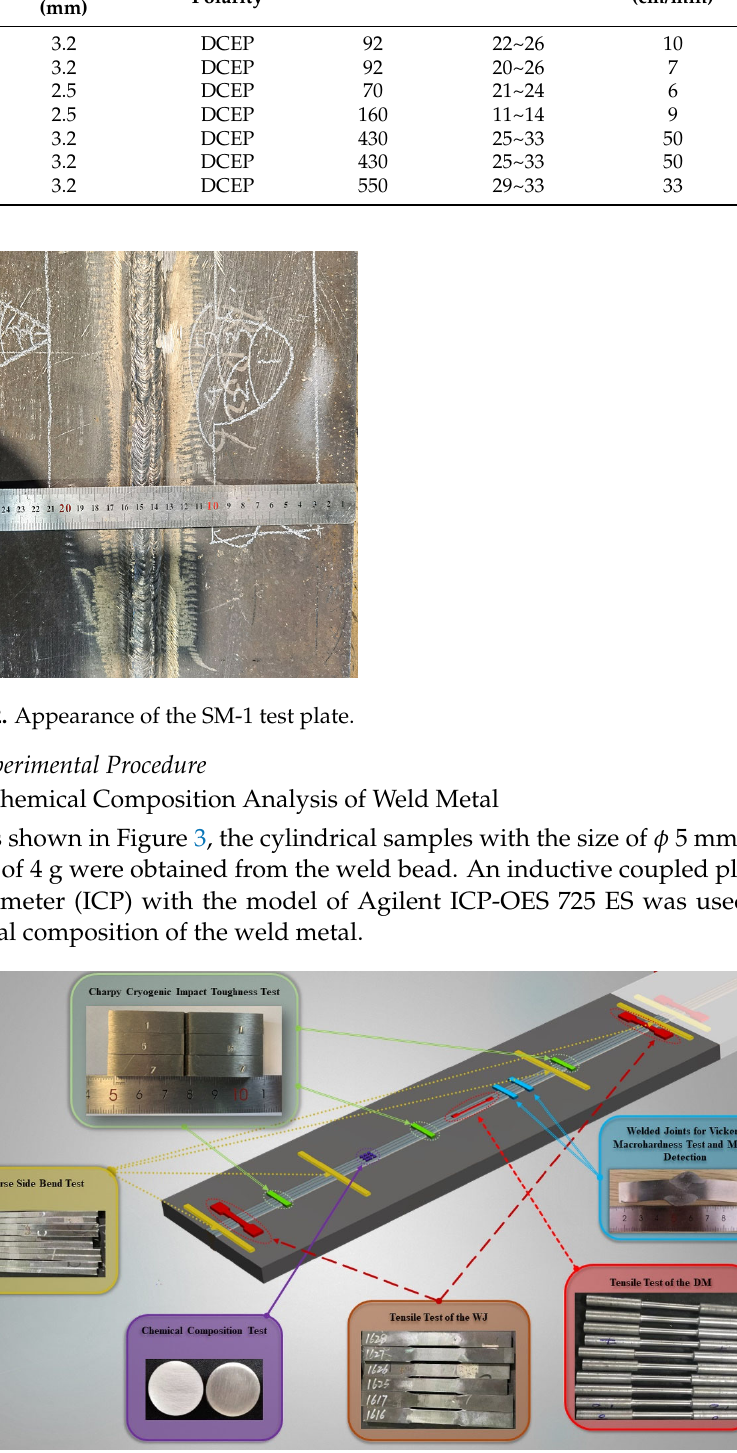
Figure 3. Schematic diagram of experimental sample (WJ: welded joint, DM: deposited metal).